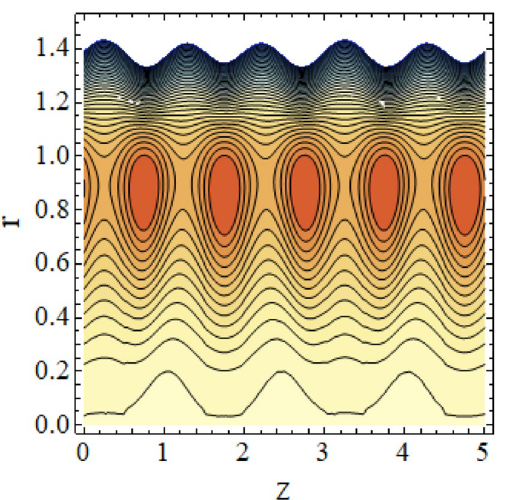
Figure 19. Streamlines for σ l = 0.07 with (cid:31) 1 = 0.4, φ = 0.037, a = 0.01, z d 1 = 0.5, z d 2 = 2, z d 3 = 3.5, h 1 = 0.5, h 2 = 2, h 3 = 3.5, Q =